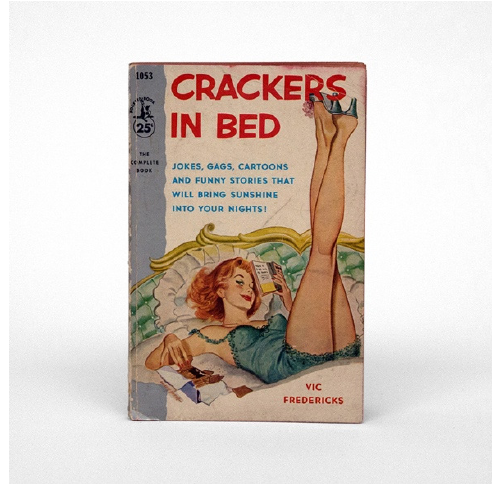
Figure 7. Vic Fredericks, Crackers in Bed , 1954.